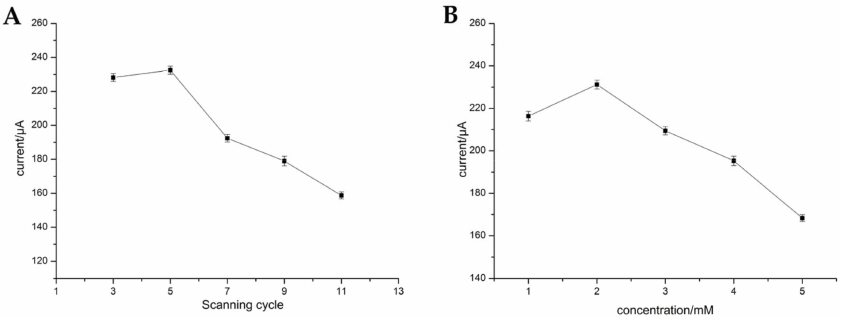
Figure 3. Dependence of the electrochemical signal on scanning cycle ( A ) and concentration ( B ) of p